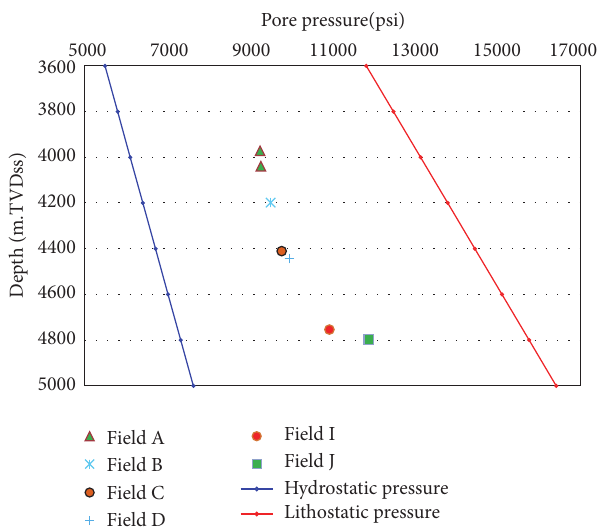
Figure 7: The reservoir pressure versus depth in all six different fields. The uppermost pressure measurements in the Lower Fahliyan reservoir have been selected in each